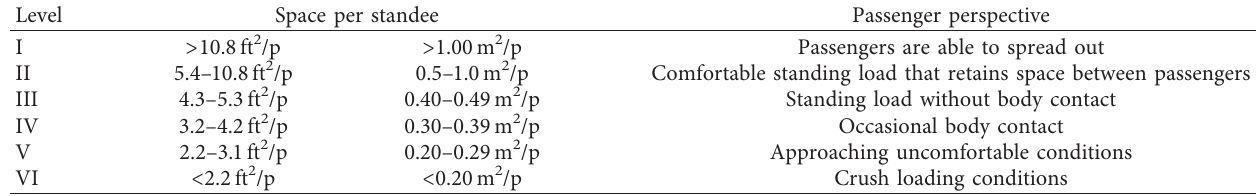
Table 2: Levels of